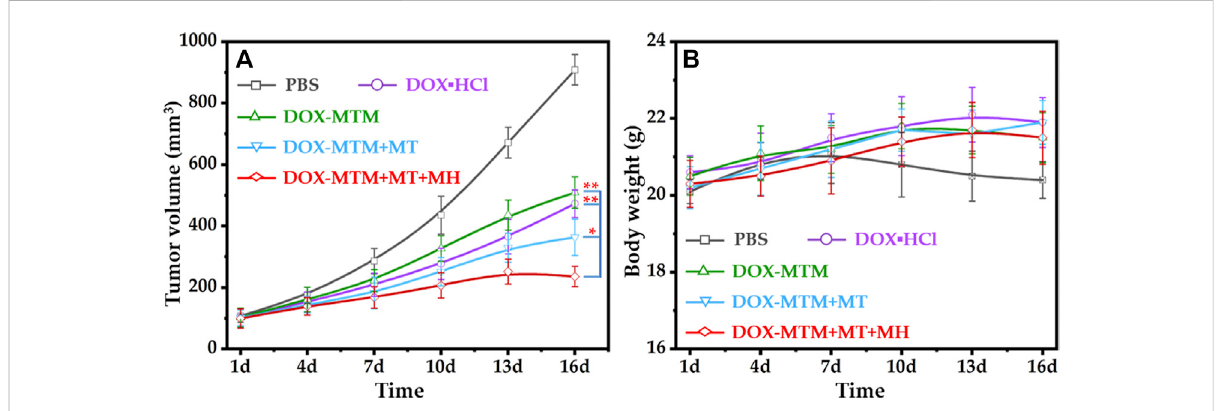
FIGURE 9 In vivo anti-tumor activities of different treatments: (A) the tumor volume curves after different treatments with the extension of curative time from 1 to 16 d (* p < 0.05; ** p < 0.01); (B) the body weight curves after corresponding treatments with the extension of curative time from 1 to 16